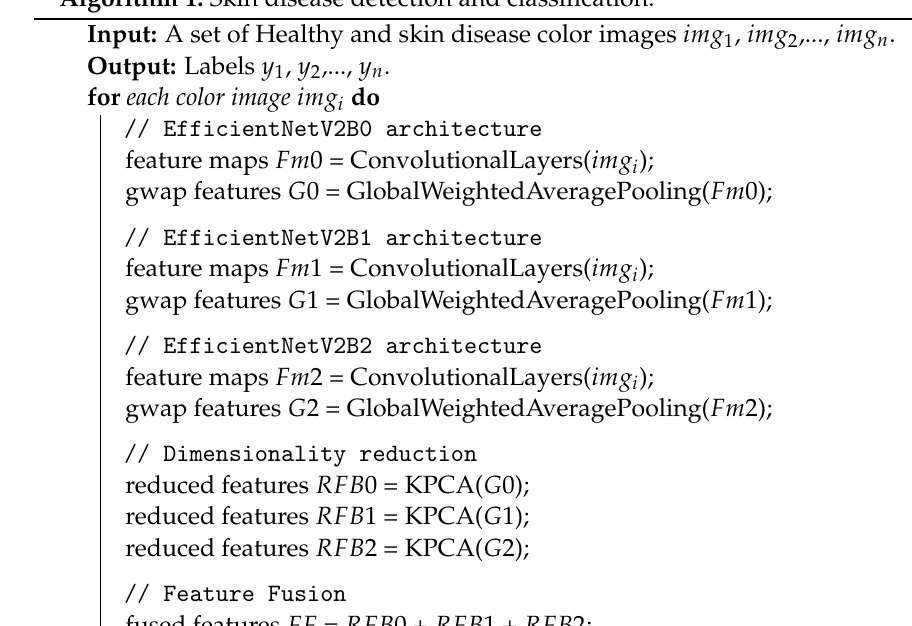
Algorithm 1: Skin disease detection and